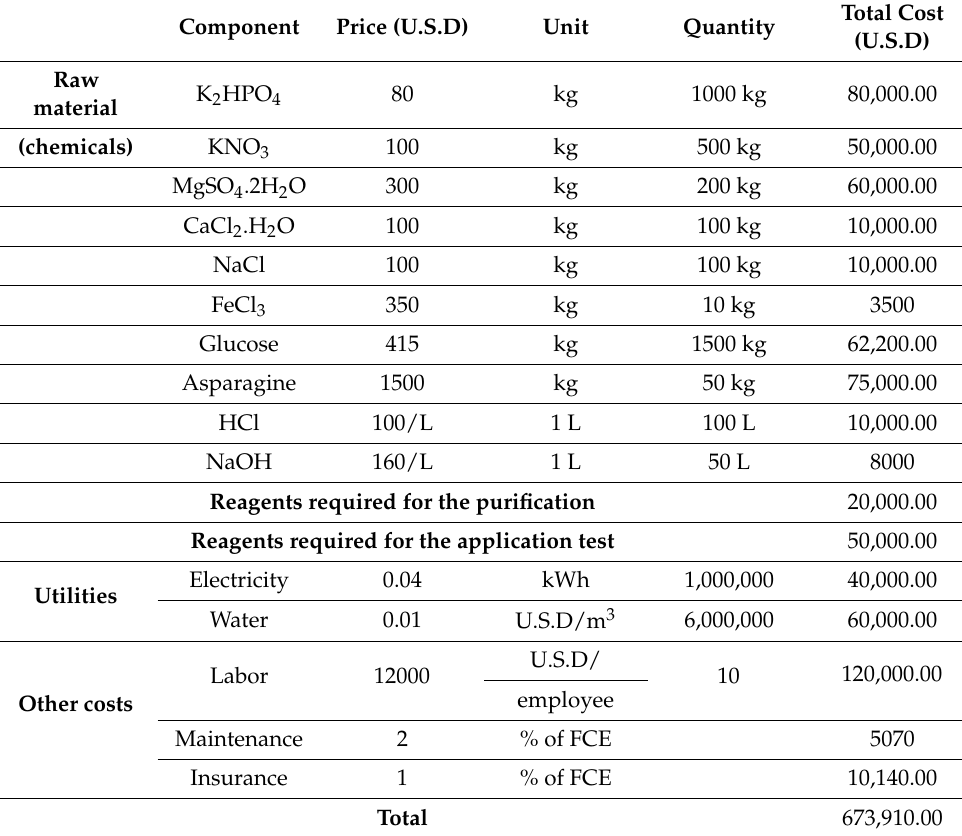
Table 5. Annual operation cost of the production of PhACs in submerged fermentation unit using Thornton’s medium after optimization via